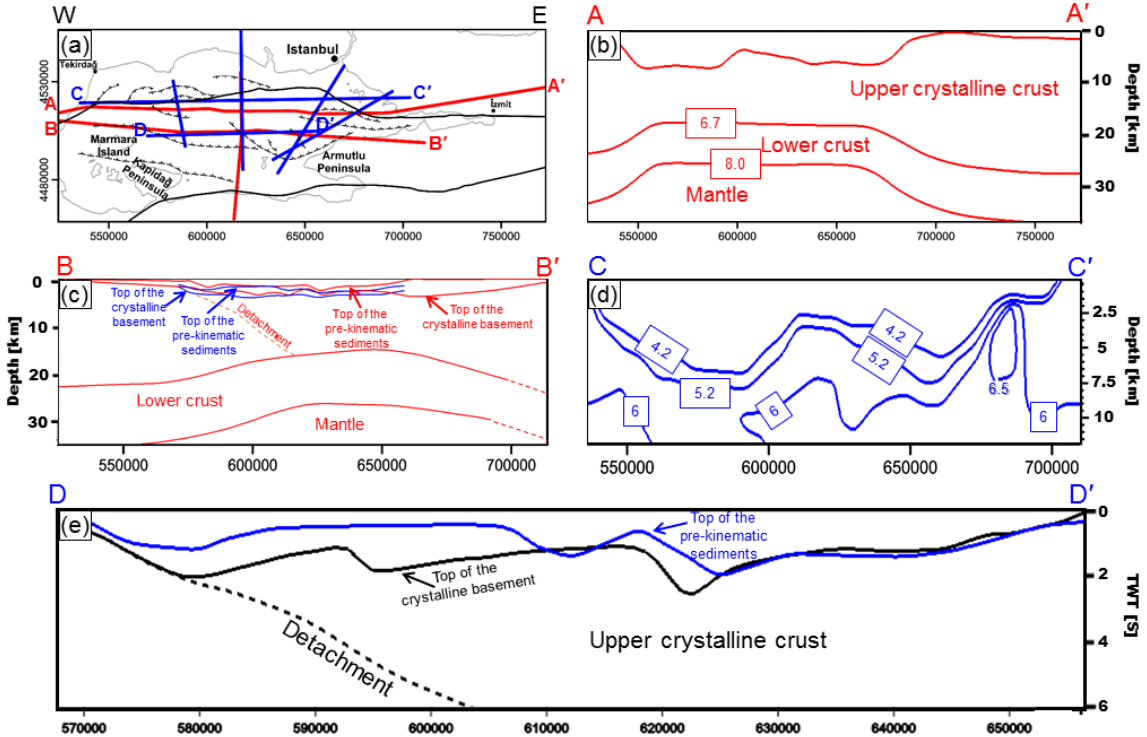
Figure 4. Location of seismic profiles considered in this study and corresponding P-wave velocities and interpretations (modified after Laigle et al., 2008; Bécel et al., 2009; Bayrakci et al., 2013). (a) Location of the seismic profiles. Red lines are from reflection–refraction survey (Bécel et al., 2009), and blue lines are from sediment–basement tomography (Bayrakci et al., 2013). (b) Crustal structure and depth to Moho along the AA (cid:48) cross-section. (c) Crustal structure and depth to Moho along the BB (cid:48) cross-section, including interpretations of the tomographic results along the DD (cid:48) profile. (d) P-wave velocity contours form the tomographic modeling along the CC (cid:48) profile. (e) Tomographic modeled iso-velocity of 4.2kms − 1 (blue line) representing top of the pre-kinematic sediments in two-way travel time along the DD (cid:48) profile, and multichannel reflection seismic interpretation form Laigle et al. (2008) on the same profile. Numbers are modeled P-wave velocities for base syn-kinematic sediments (4.2kms − 1 ), base pre-kinematic-sediments (5.2kms − 1 ), top of the lower crust (6.7kms − 1 ), and the Moho discontinuity (8kms − 1